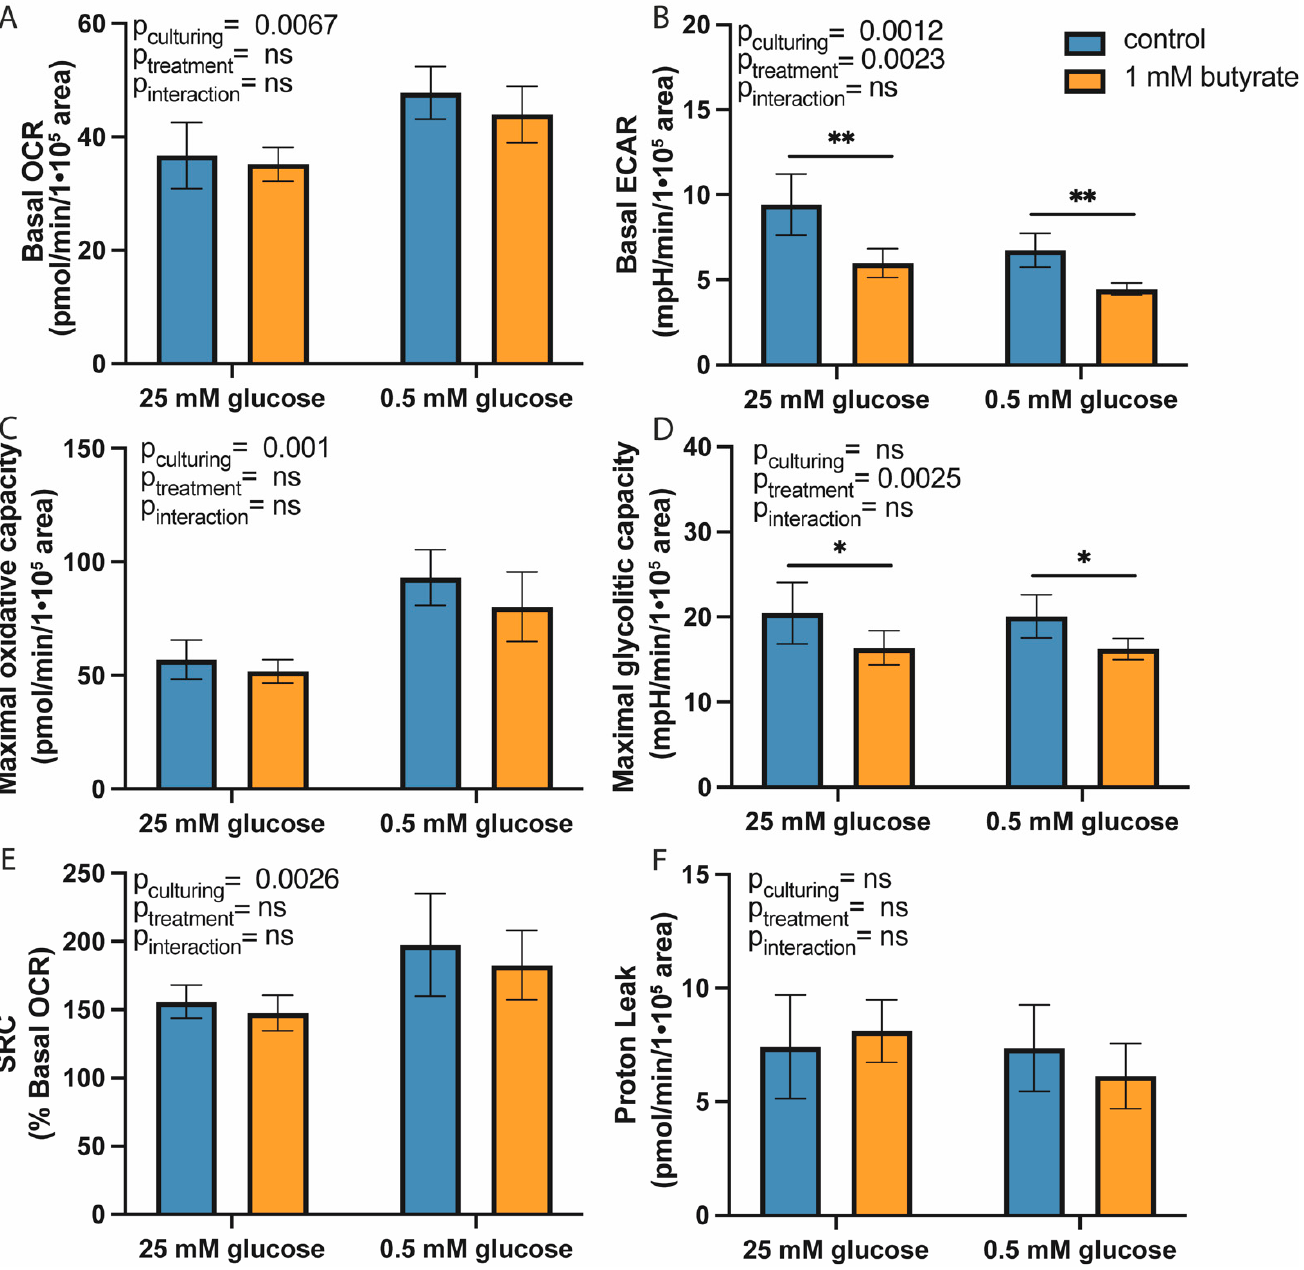
Figure 1. Metabolic flux analysis of high- and low-glucose-cultured HT29 cells following 72 h exposure to 1 mM butyrate. ( A ) Basal OCR. ( B ) Basal ECAR. ( C ) Maximal oxidative capacity. ( D ) Maximal glycolytic capacity. ( E ) SRC (%) and ( F ) Proton leak. ( N = 3. Data are presented as mean ± SD; significance was determined using two-way ANOVA with factors culturing (25 mM or 0.5 mM glucose level in culture medium) and treatment (only medium or butyrate exposure), followed by Bonferroni post-hoc analysis. * = p < 0.05, ** = p < 0.01).